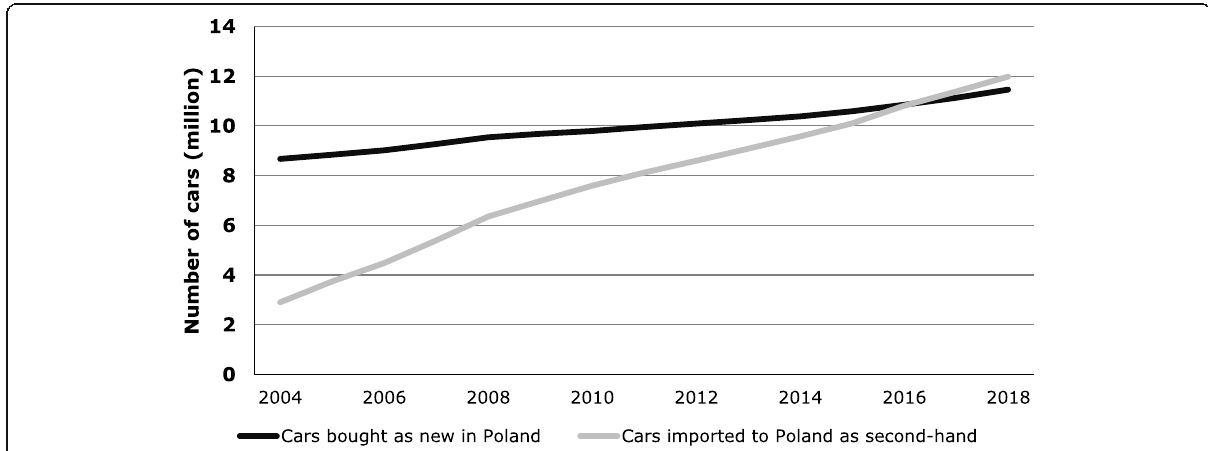
Fig. 5 Change in the dynamics of the number of cars bought as new and imported as second-hand in Polish car fleet after the accession to the EU. Source: own elaboration based on the Ministry of Finance and Central Vehicle Agency